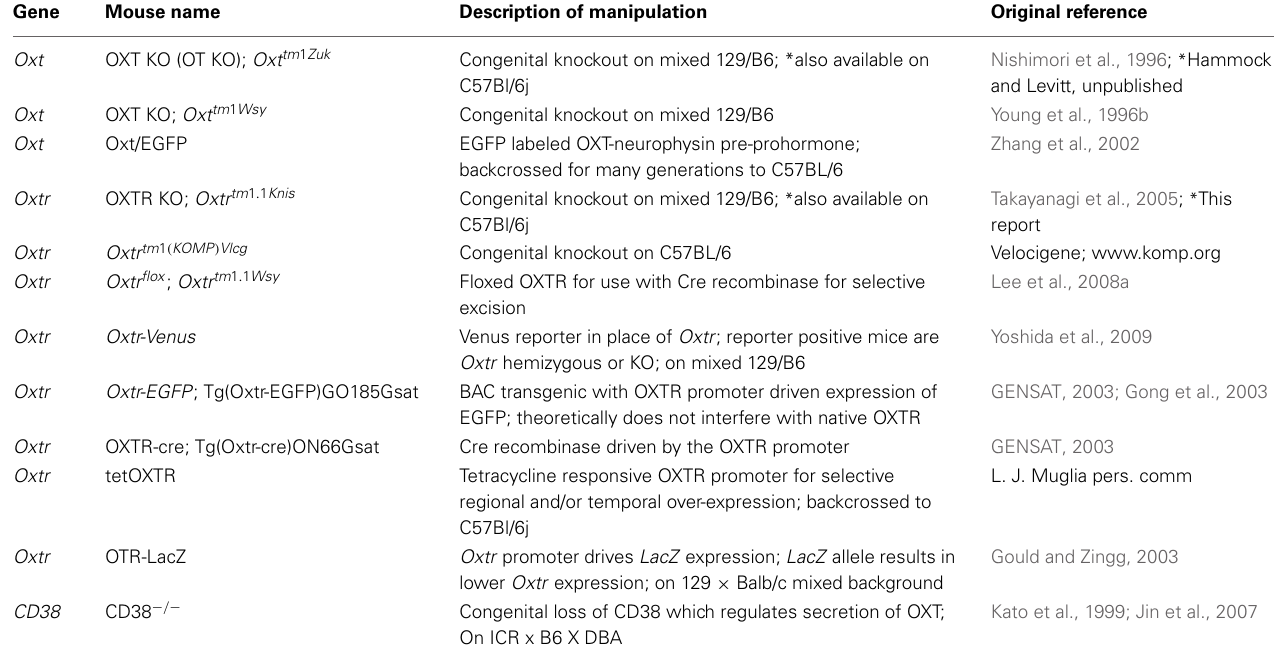
Table 1 | Mouse models of oxytocin system